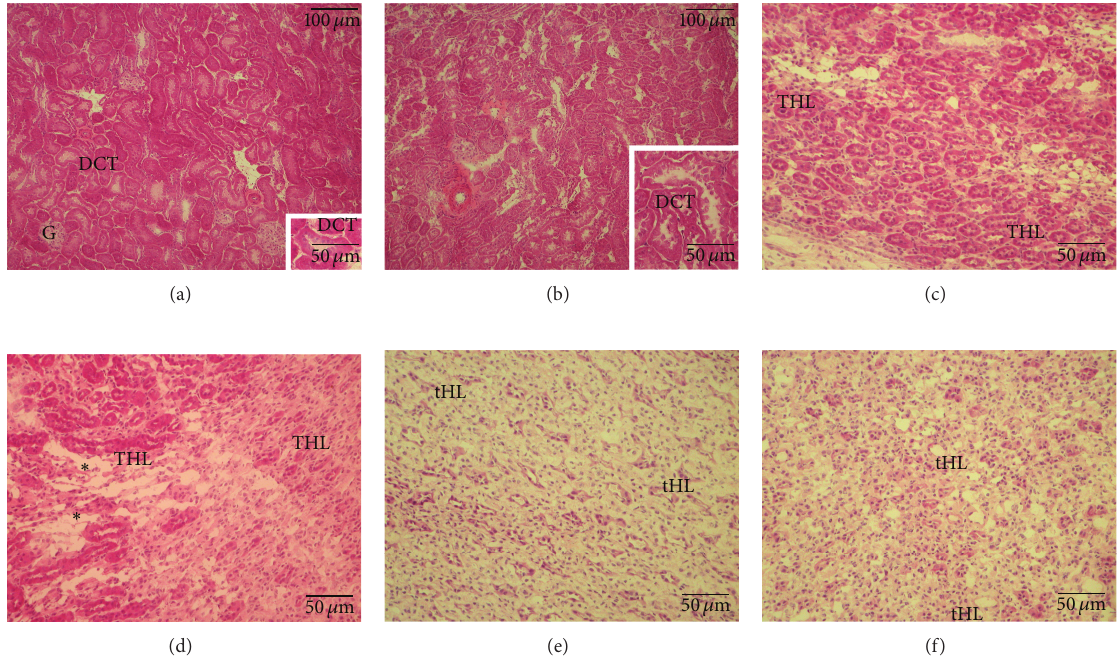
Figure 4: Representative light micrographs of kidney samples obtained from sham-operated rats (a, b, and c) and from rats submitted to hepatic ischemia/reperfusion (I/R) (d, e, and f). Cortex (a, b), outer medulla (c, d), and inner medulla (e; f) are illustrated. Hematoxylin and eosin staining. With respect to the normal morphology of the cortex of sham animals (a), the cortex of animals submitted to hepatic I/R (b) shows dilated interstitium and injury to a few tubules. The insets in (a) show a normal distal convolute tubule (DCT) and in (b) patchy areas of dilatation. With respect to the normal morphology of the outer medulla of sham animals (c), the outer medulla of animals submitted to hepatic I/R shows extended areas of interstitial fluid (asterisk) apparently displacing thick limbs of Henle’s loop (THL). Respect to the inner medulla of sham animals (e), the inner medulla of animals submitted to I/R (f), shows slightly dilated thin limbs of Henle’s loop (tHL) and increased cellularity in the